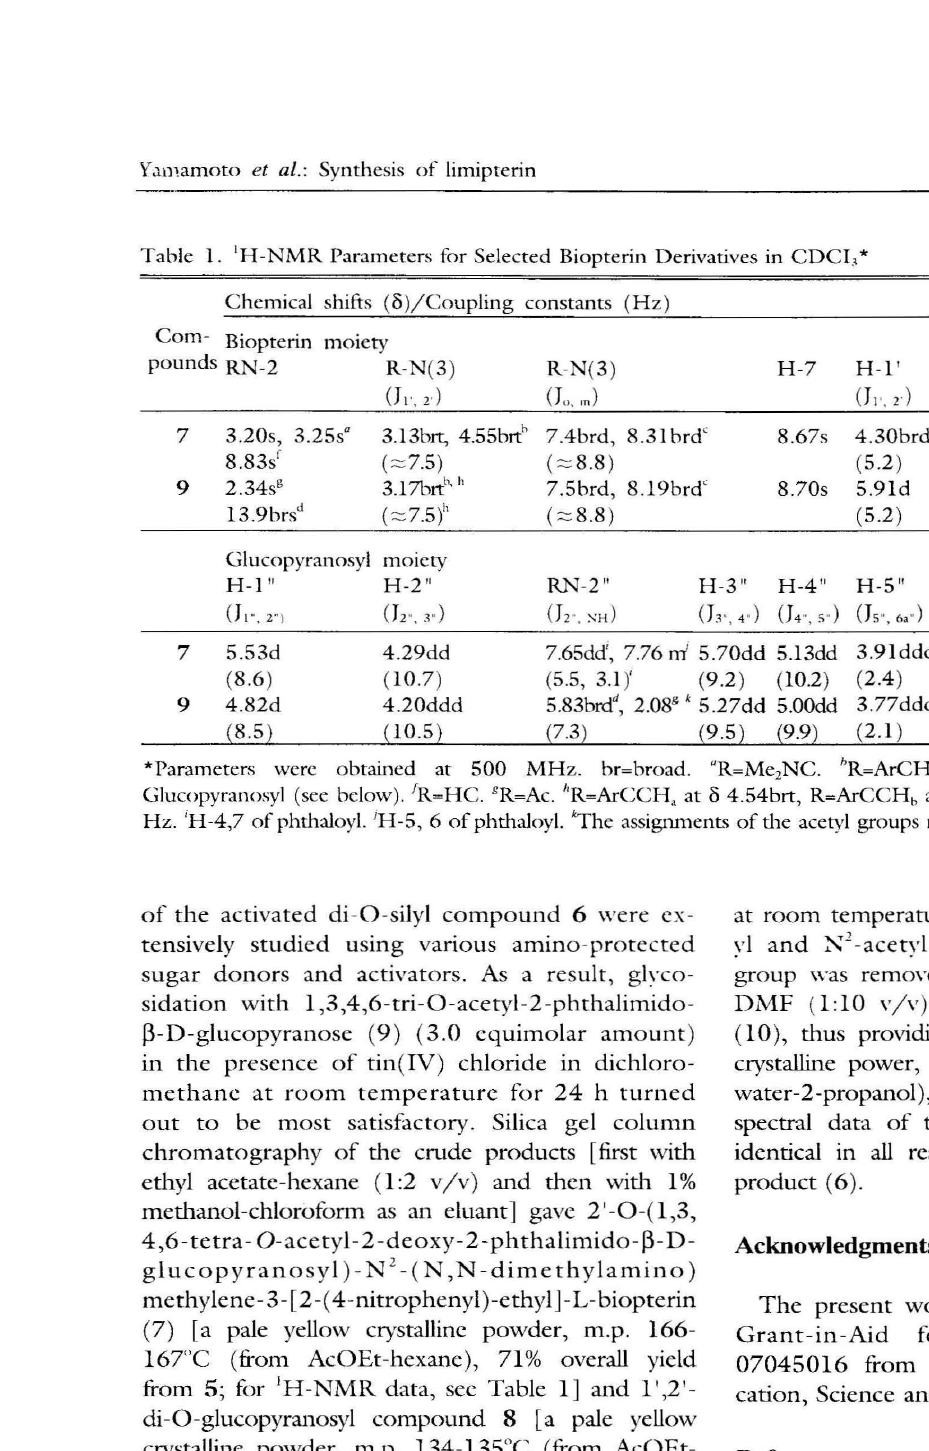
Table 1 J. This (o::1:'ound was treated with 25% aqueous ammoniu:': 1\ ciroxide-methanol (2:5